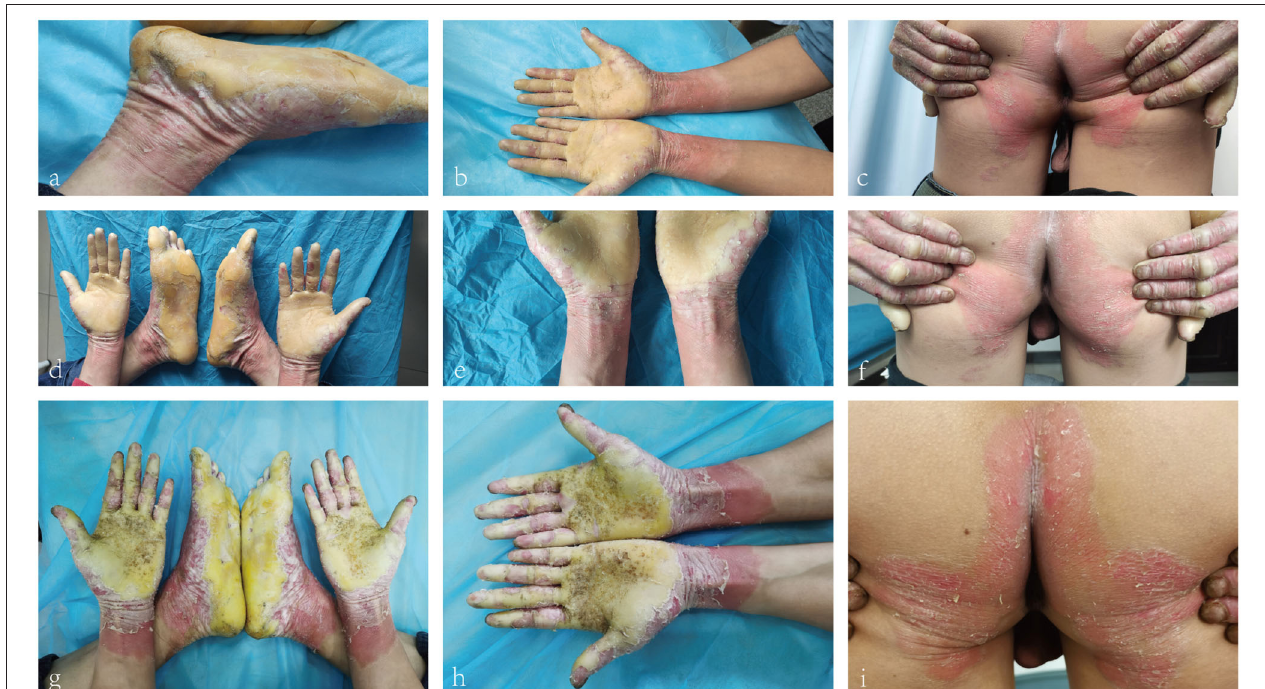
FIGURE 1 | (a–c) Waxy, thick, pale-yellow scales on the palms and soles. Crimson erythema with a little scale on buttocks. (d–f) Retraction of erythema edge on the forearm and pale erythema on buttocks. (g–i) Crimson erythema on the forearm and buttocks. Increased area of forearm